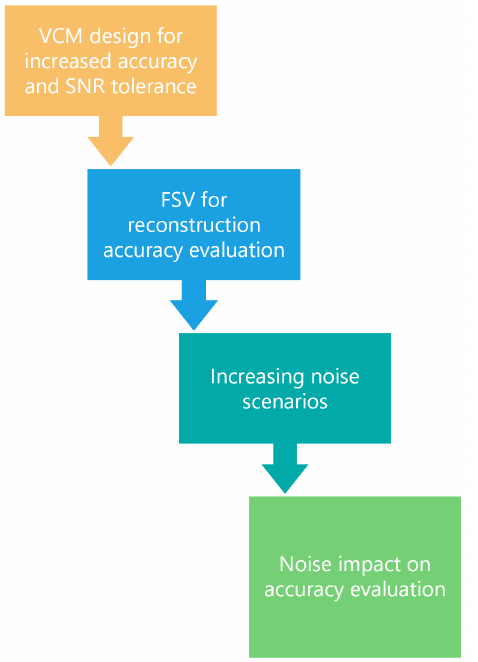
Figure 14. Summary of the signal-to-noise tolerance improvement and evaluation.